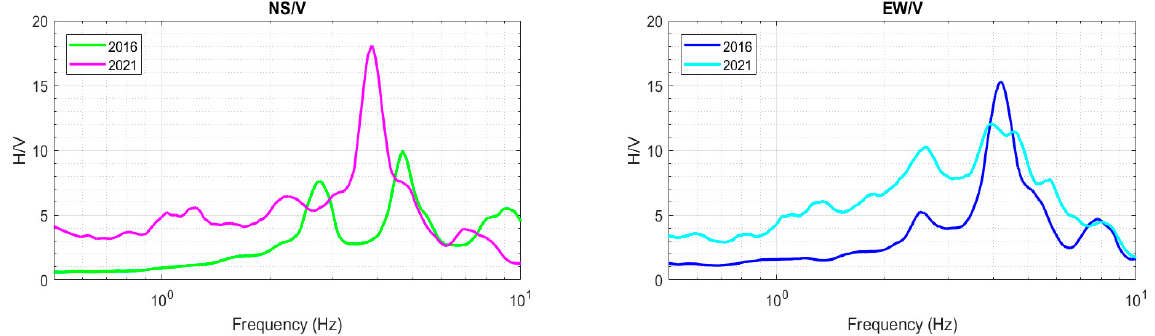
Figure 7. Comparison between ambient noise measurements carried out in 2016 and 2021 on the Castle’s 2nd floor, position 1.